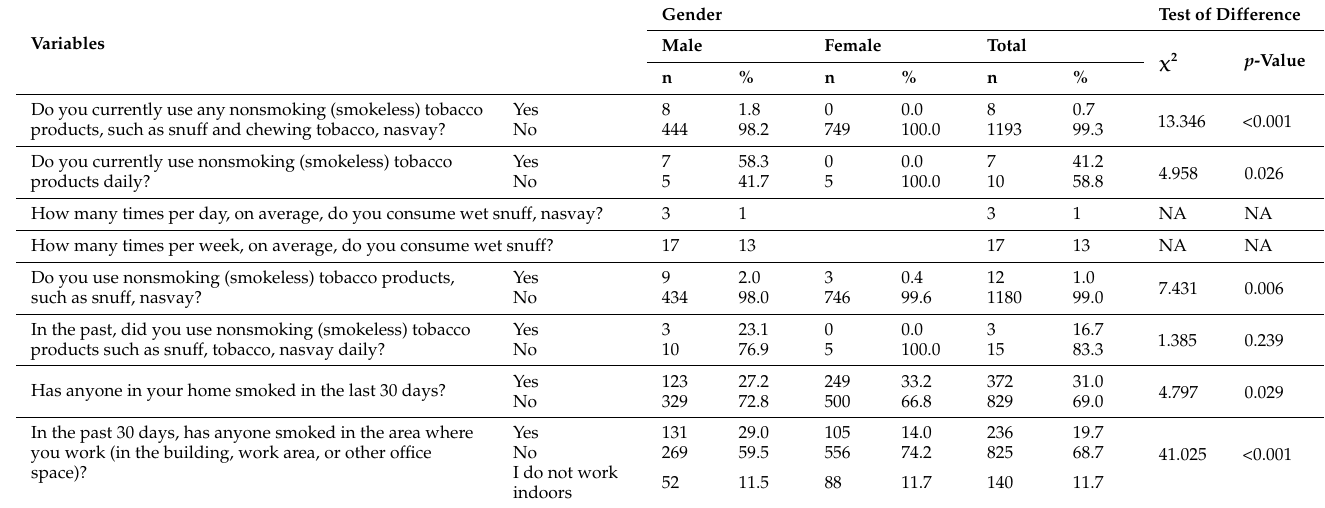
Table 6. Characteristics of smoking status of smokeless tobacco products, n =